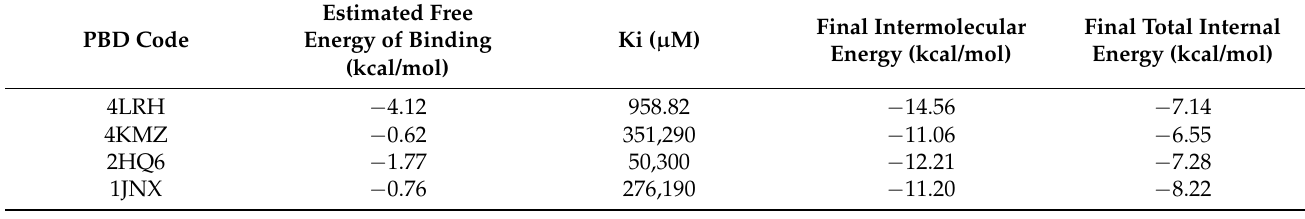
Table 1. The dock evaluation of receptor protein and BA F G 2 .